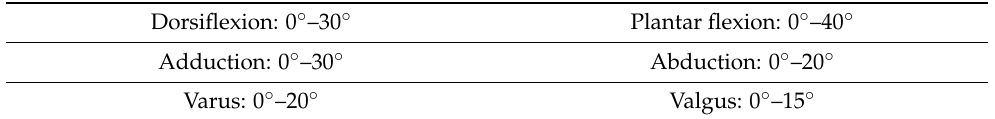
Table 1. Motion range of the ankle